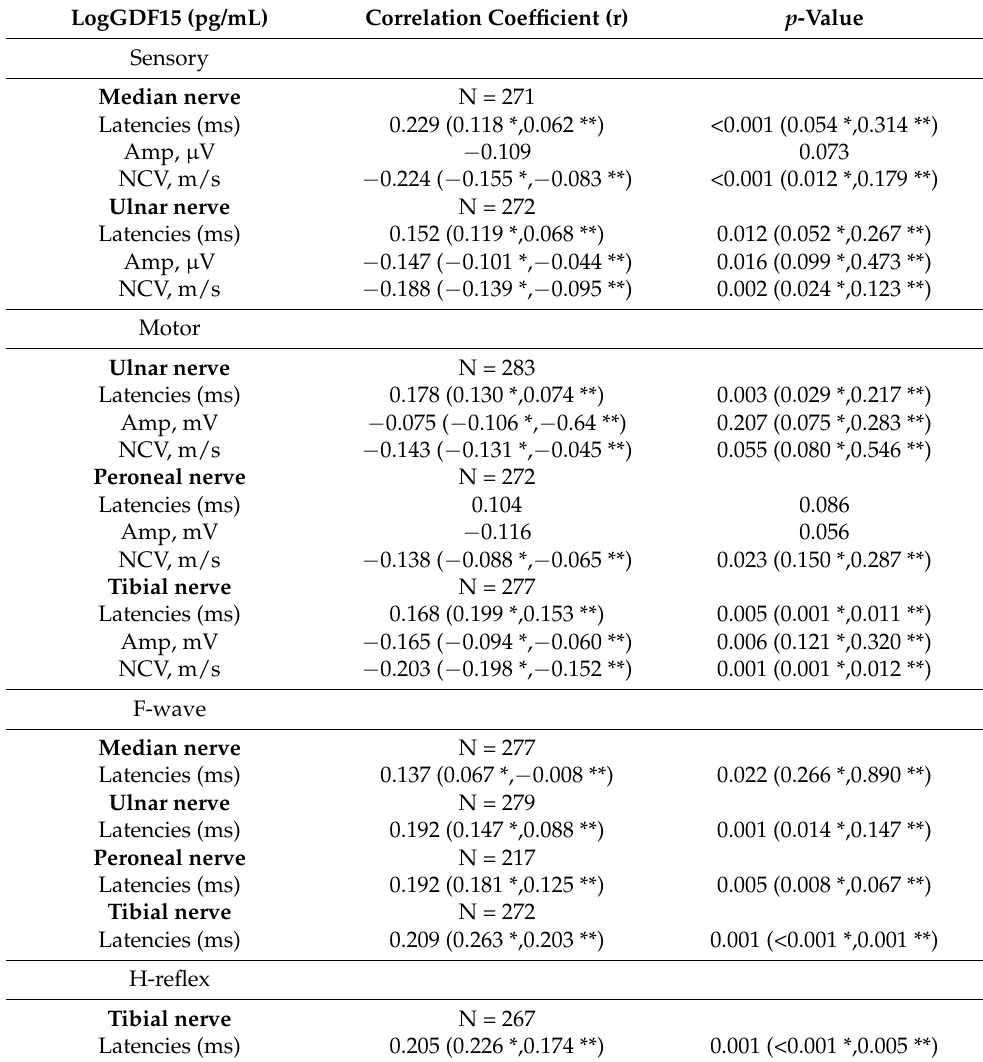
Table 5. Correlation between GDF15 and nerve conduction